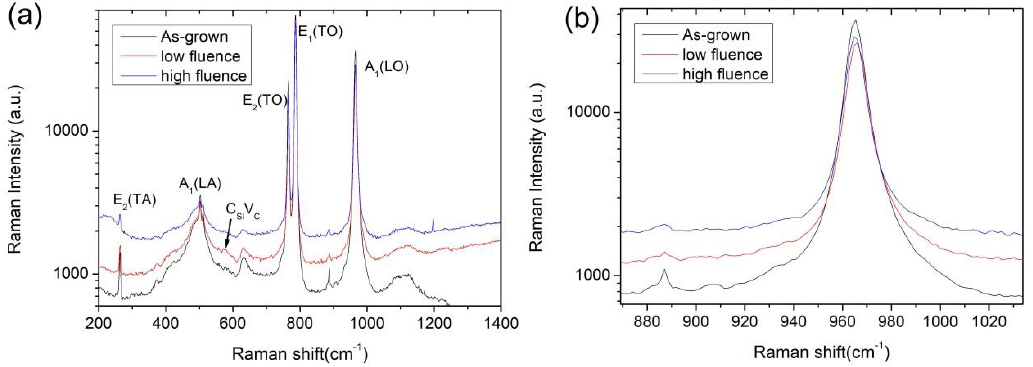
Figure 1. ( a ) Raman spectra of 6H-SiC irradiated with He and H 2 ions at a low fluence (1.5 × 10 16 He + /cm 2 + 5 × 10 16 H 2+ /cm 2 ) or a high fluence (5 × 10 16 He + /cm 2 + 5 × 10 16 H 2+ /cm 2 ) at RT(Room tem- perature) followed by 1100 °C annealing for 15 min. ( b ) Zoom-in on A 1 (LO) peaks at different flu- ence